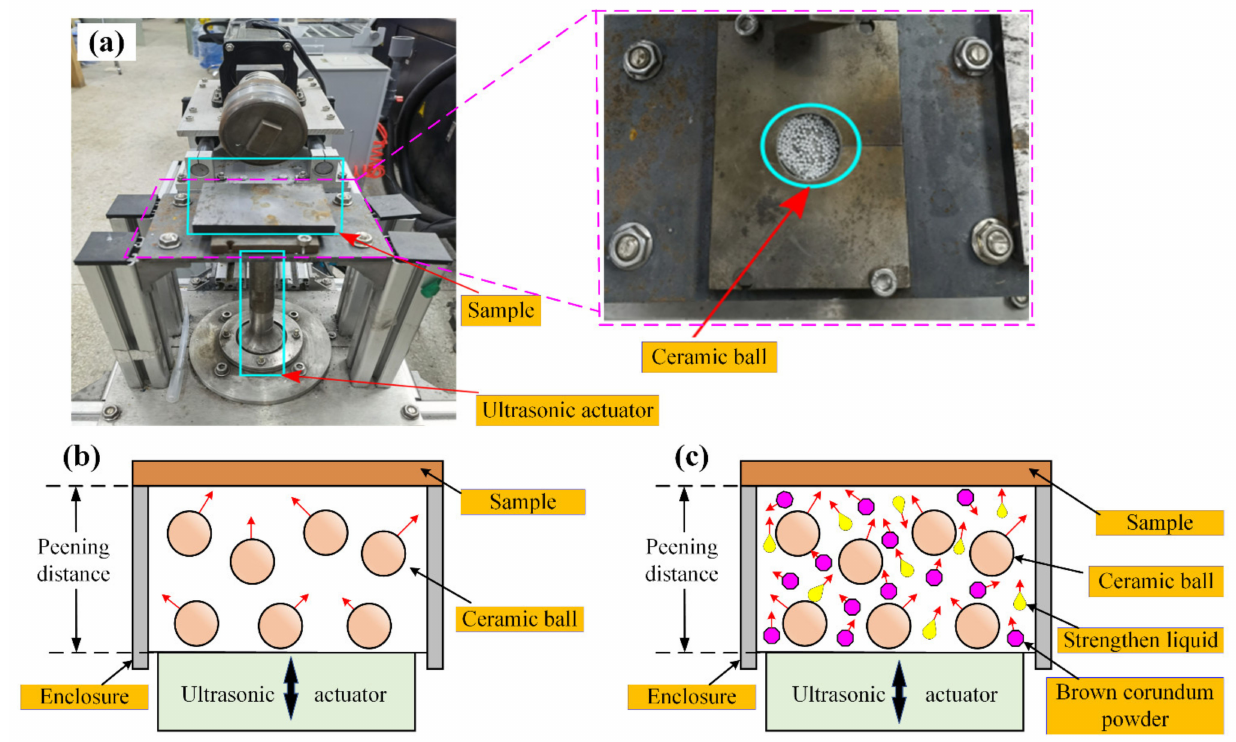
Figure 2. Schematic of the ultrasonic processing equipment ( a ), USP treatment ( b ), and USGP processing ( c